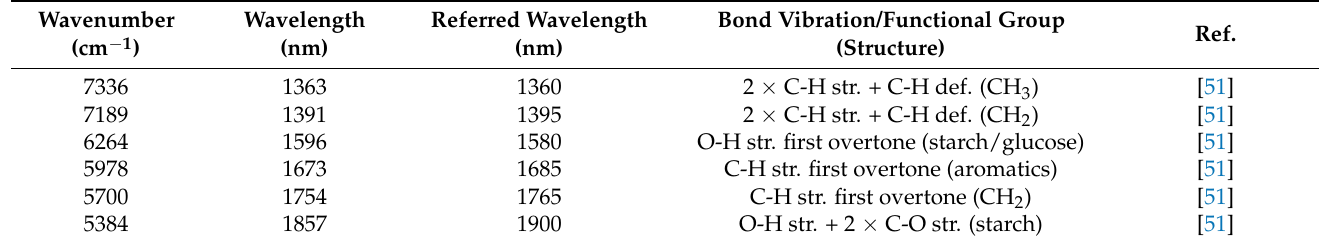
Table 8. The bands with a high regression coefficient of the PLSR model for TSS in mango pur é e. Wavenumber